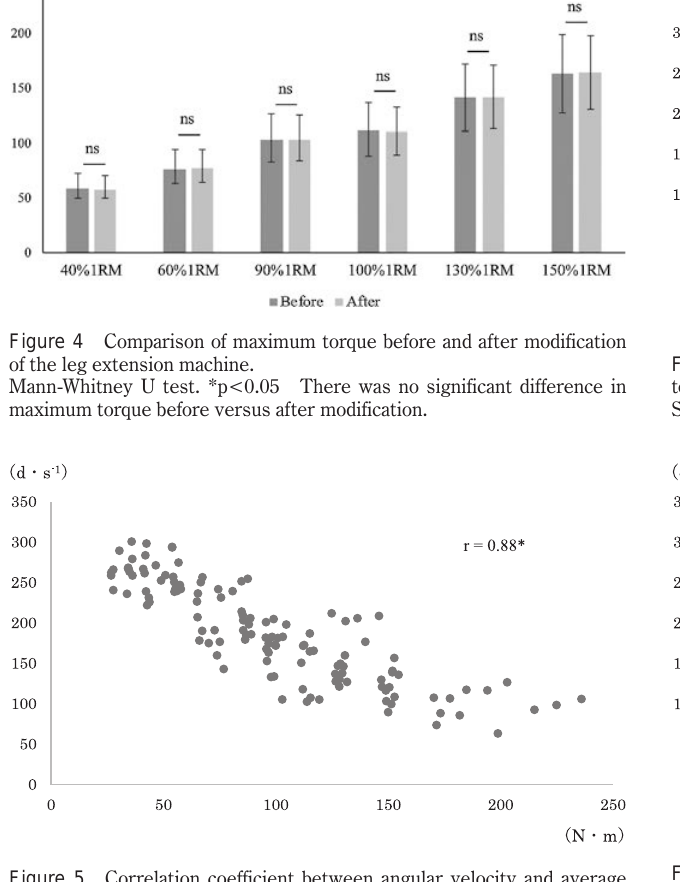
Figure 5 Correlation coefficient between angular velocity and average torque before modification of the leg extension machine. Spearman’s rank correlation coefficient. *p<0.01